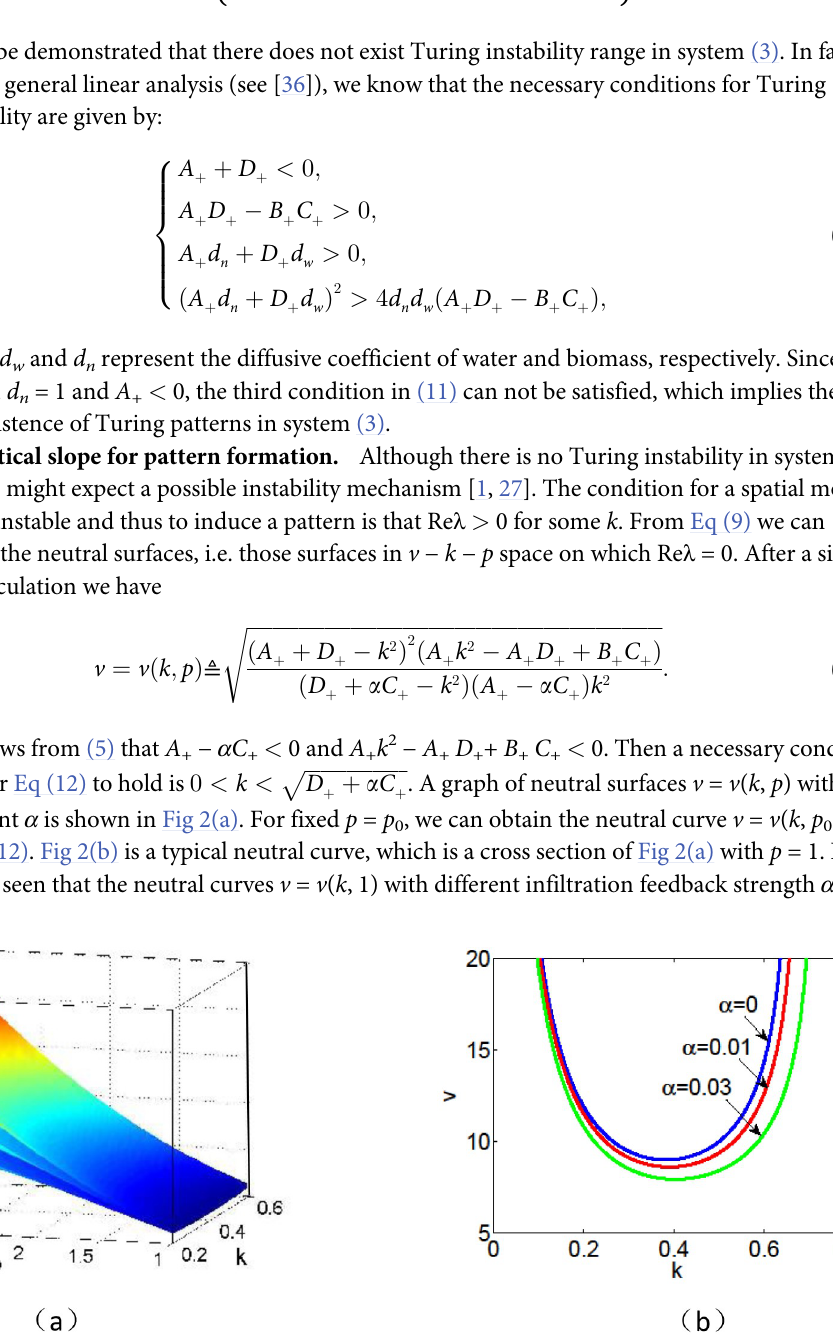
Fig 2. (a) Neutral surfaces v = v ( k , p ) defined in Eq (12) with the parameter values v = 182.5 and δ = 0.45; (b) Typical neutral curve v = v ( k , 1) with the parameter values v = 182.5, δ = 0.45 and p = 1. One can see that the critical advection strength v c decrease with the increase of infiltration feedback strength α